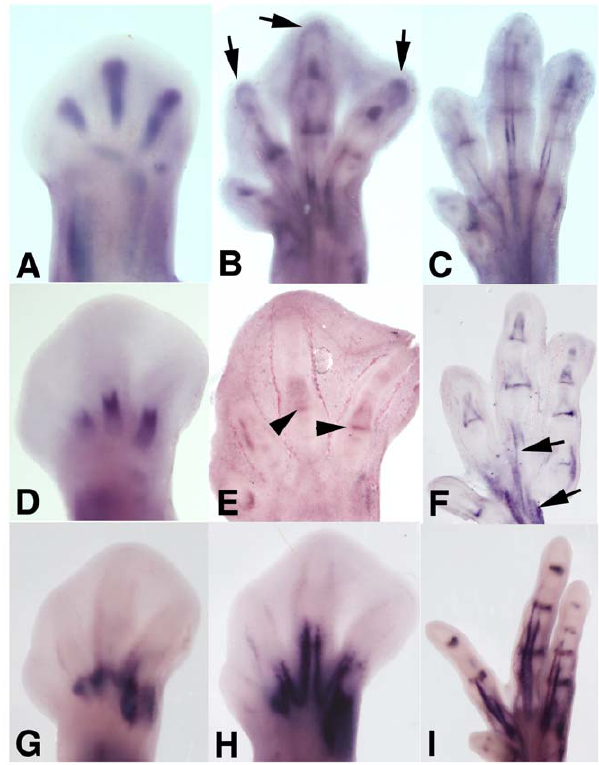
Figure 3. Expression of Ccn1 (A–C), Ccn2 (D–F), and Ccn3 (G–I), in the developing digits at days 5,5–6,5 (A,D,G), 7–8 (B,E,H) and 8,5–9 (C, F, I) of incubation. A–C, Intense expression of Ccn1 is first seen in the digit blastemas (A), and in the course of development, expression becomes restricted to the digit tips (arrow), joints and tendons (B). Note in C the disappearance of the digit tip domains once all of the phalanxes have formed. D–F, Expression of Ccn2 is first associated with the zones of hypertrophic differentiation of digit cartilage (D) followed by the appearance of joint domains (arrowheads, B) and then tendons domains (arrows, E). G–I, Expression of Ccn3 first appears in the developing tendons (G,H) and then extends to the developing joints